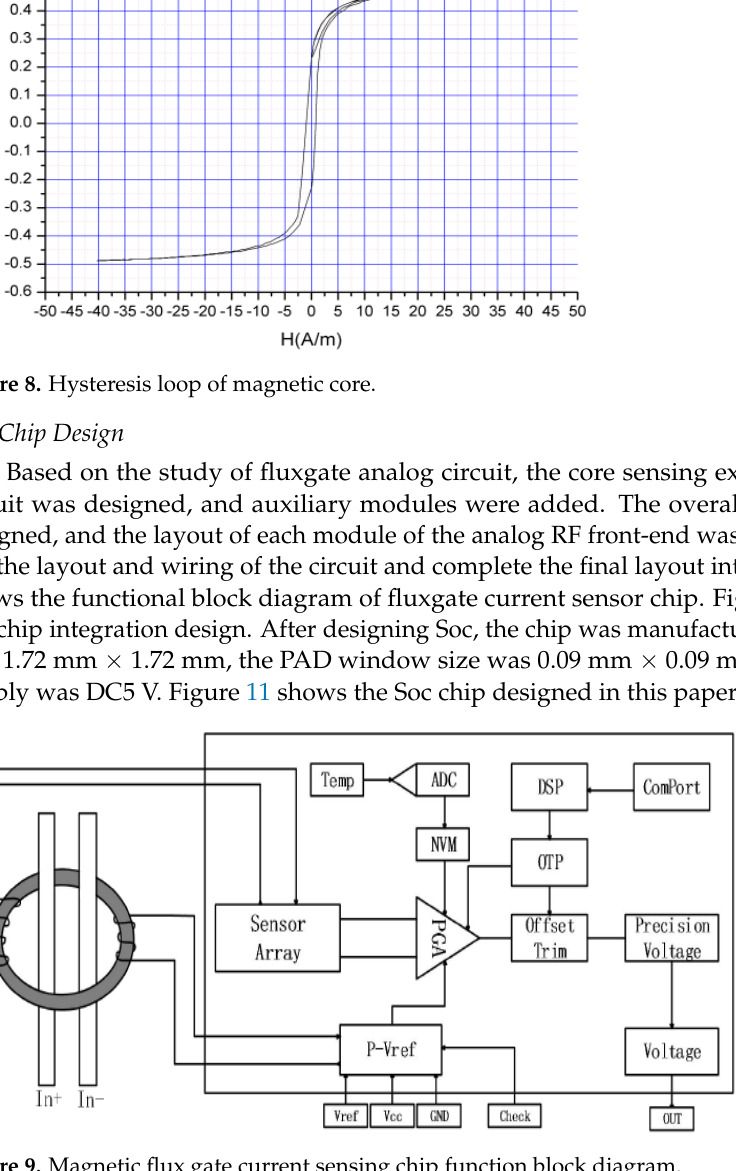
Figure 10. Integrated design diagram of SOC chip.